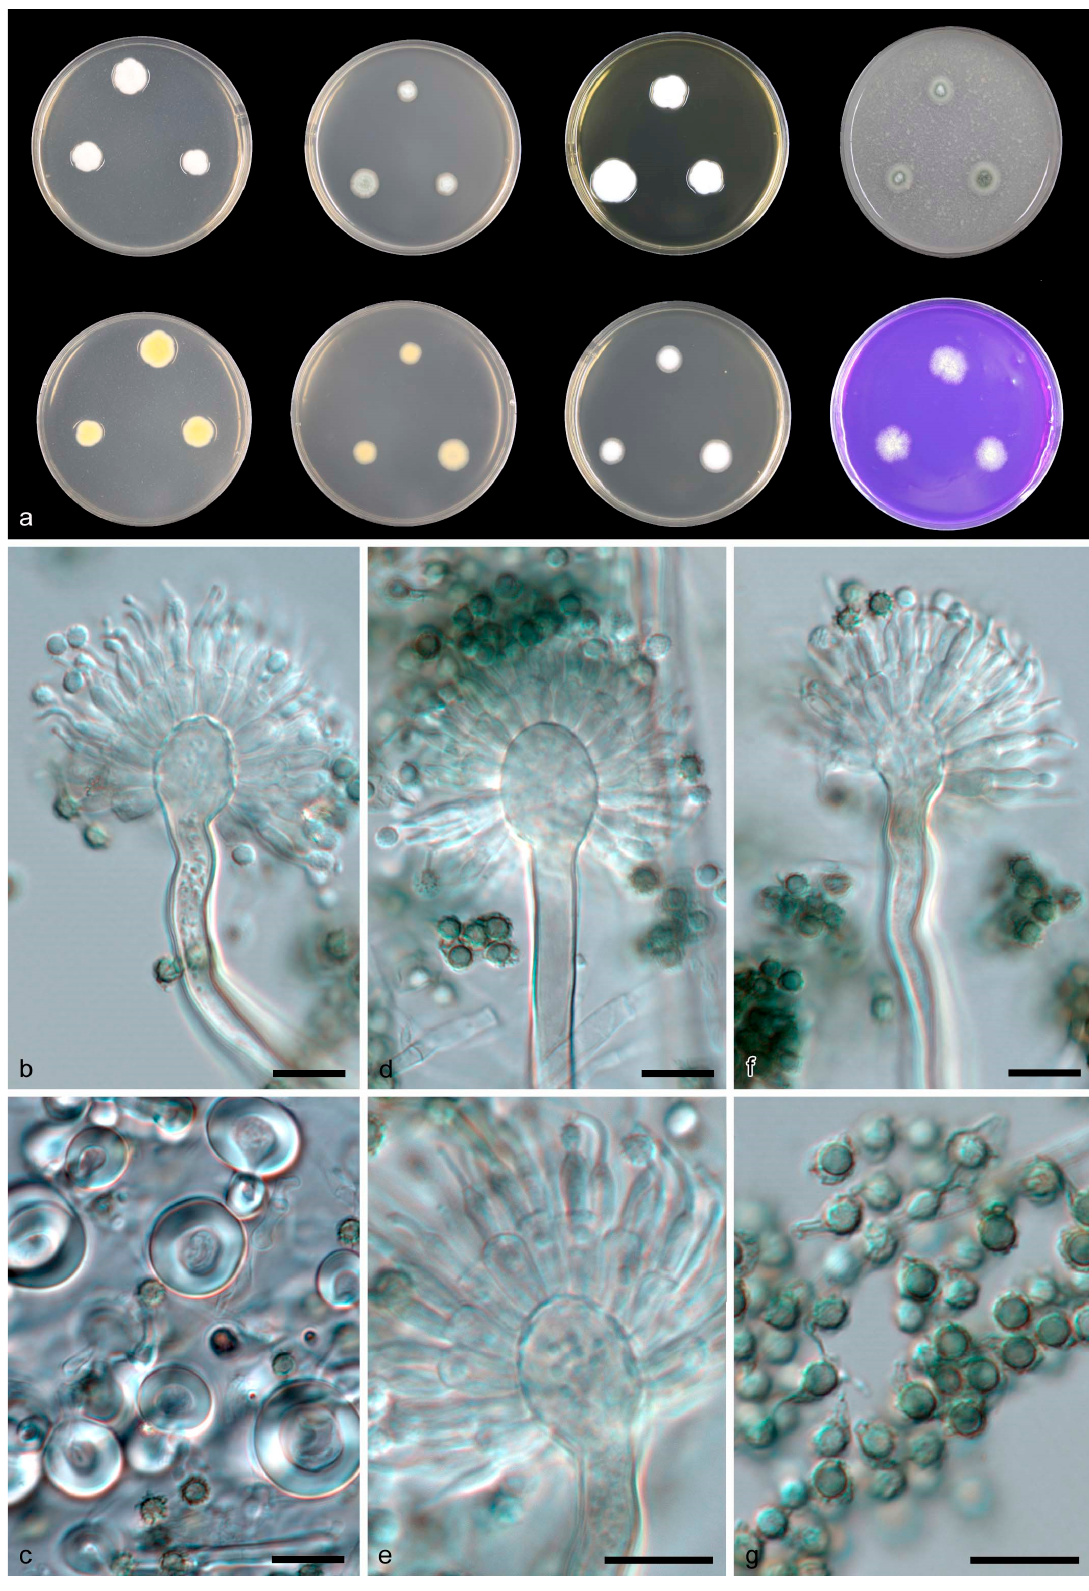
Figure 4. Aspergillus sichuanensis CGMCC 3.19705 T. ( a ) Colonies: top row left to right, obverse CYA, obverse MEA, YES and OA; bottom row left to right, reverse CYA, reverse MEA, DG18 and CREA. ( b , d – f ) Conidiophores. ( c ) Hülle cells. ( g ) Conidia. Scale bars: b–g = 10 μ m.